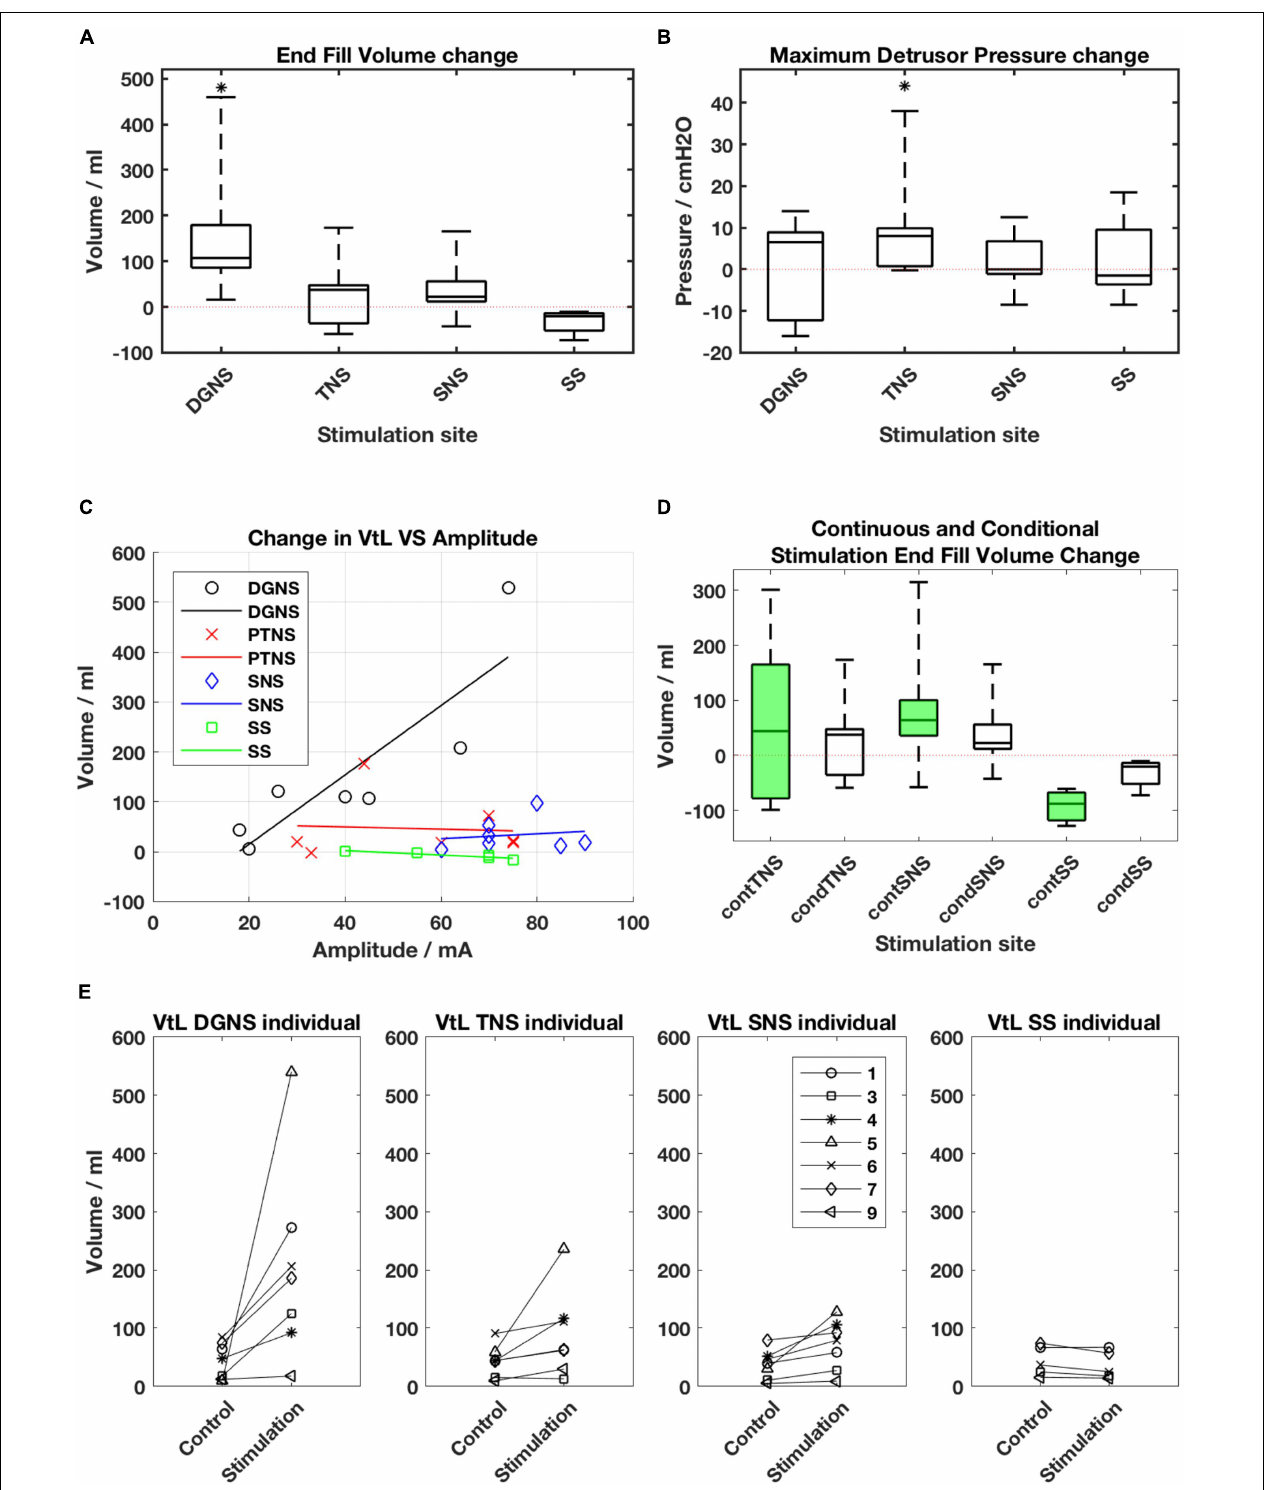
FIGURE 3 | (A) Boxplot of end fill volume and (B) Maximum Detrusor Pressure change from baseline for each site. Boxes show median, interquartile ranges, and error bars denote the range. Stars denote that change from baseline is p < 0.05 following a Wilcoxon Rank Sum test. (C) Amplitude of stimulation vs. change in Volume to Leakage (VtL) for each site. DGNS appears to deliver increased gains when applied at greater amplitudes ( R 2 = 0.75). (D) Changes from baseline in end fill volumes (EFV) in continuous (green) and conditional (white) stimulation fills. Boxes represent the median and interquartile range of within session changes in EFV, whiskers show the range. (E) Individual changes in VtL as mean values obtained during control and conditional stimulation fills from each session.